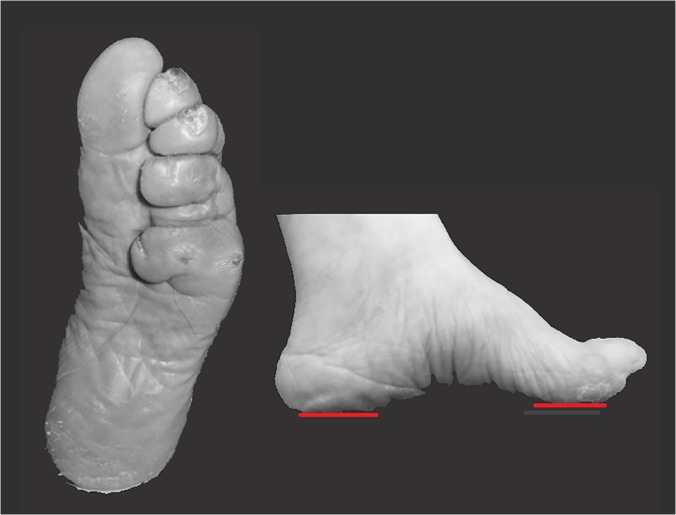
The morphology of bound feet (left: bottom view; right: medial view, the two red lines are the loading parts of bound feet during locomotion.)